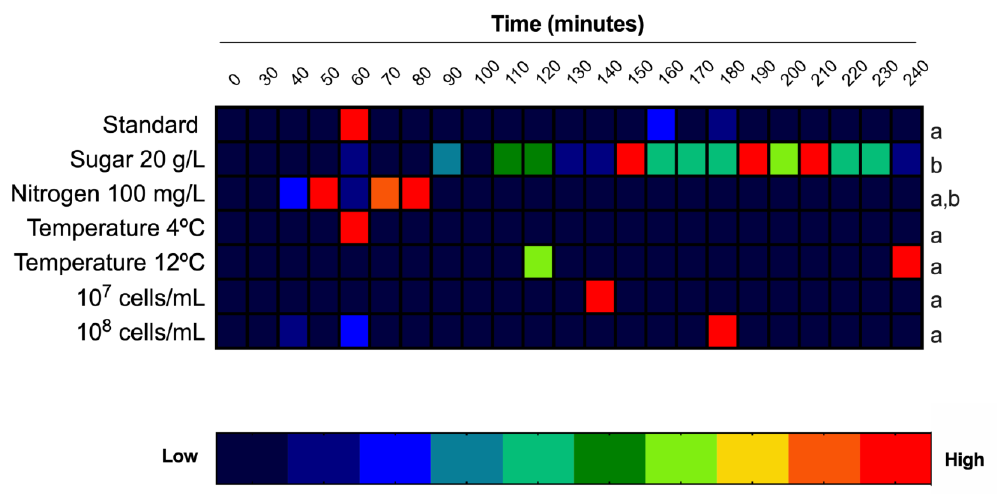
Figure 4. Heatmap of melatonin production in several fermentation conditions in S. cerevisiae QA23: Low sugar (20 g/L), low nitrogen (100 mg N/L) concentration, different temperatures and inoculum amount. Concentrations were normalized to its maximum level. Standard fermentation was grape must with 200 g/L sugar and 300 mg N/L, inoculated at 10 6 cells/mL and fermented at 28 °C. Different letters indicate significant differences between conditions, p < 0.05.